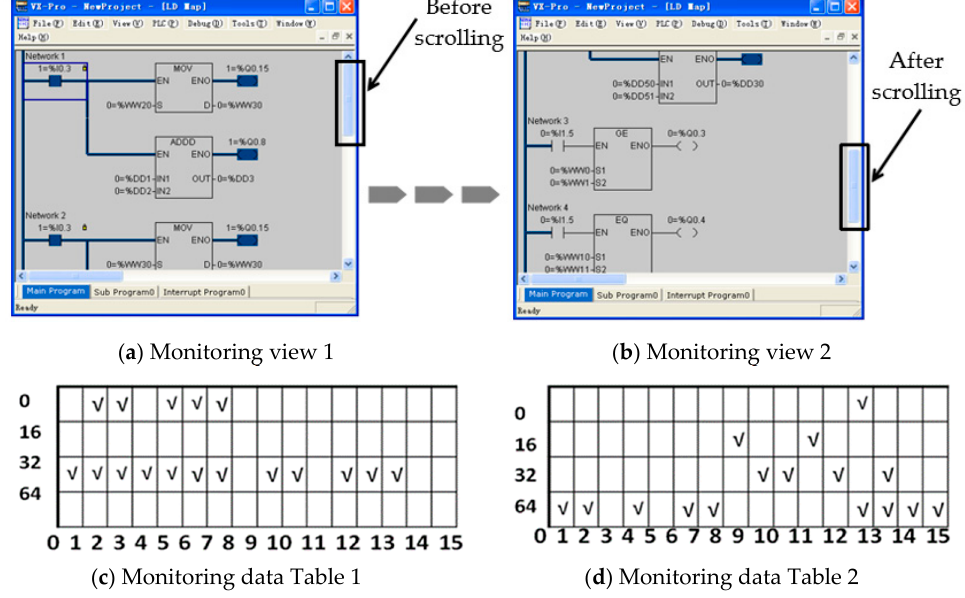
Figure 3. Illustrative examples of scrolling views and updating monitoring data.